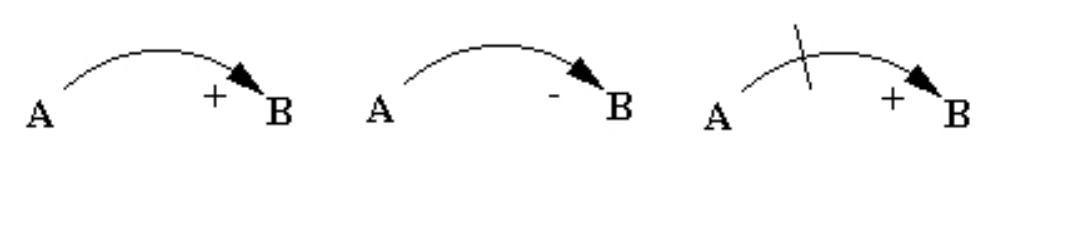
Fig. 2. Labelling conventions for causal links. The arrows indicate that a change in variable A causes a change in variable B. Each link is assigned a polarity. The polarity of the causal link between A and B is said to be positive when an increase/decrease in A causes B to increase/decrease above/below what it otherwise would have been. A causal link is negative when an increase/decrease in A causes B to decrease/ increase below/above what it otherwise would have been. A short line indicates that there is a delay between a change in A and the corresponding change in